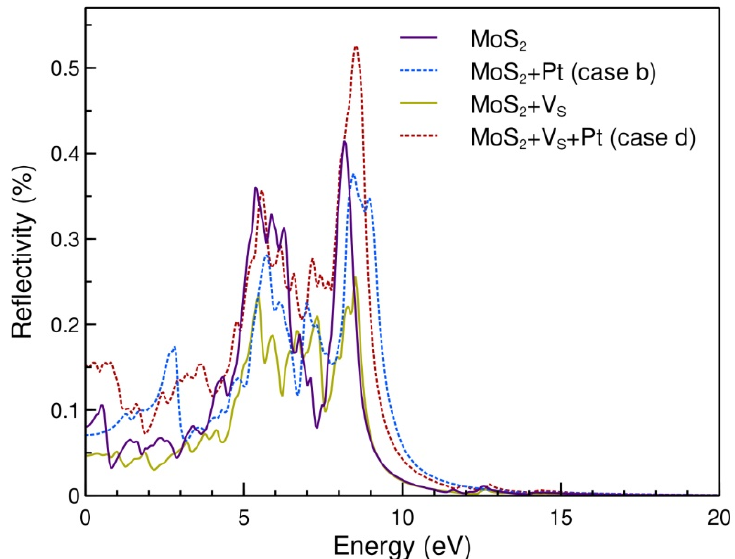
Figure 7. Reflectivity spectra for the cases considered. The substitutionally absorbed Pt atom increases the reflectivity overall. Most of the reflectivity is observed in the visible spectra, with a negligible amount observed at energies beyond 20 eV.